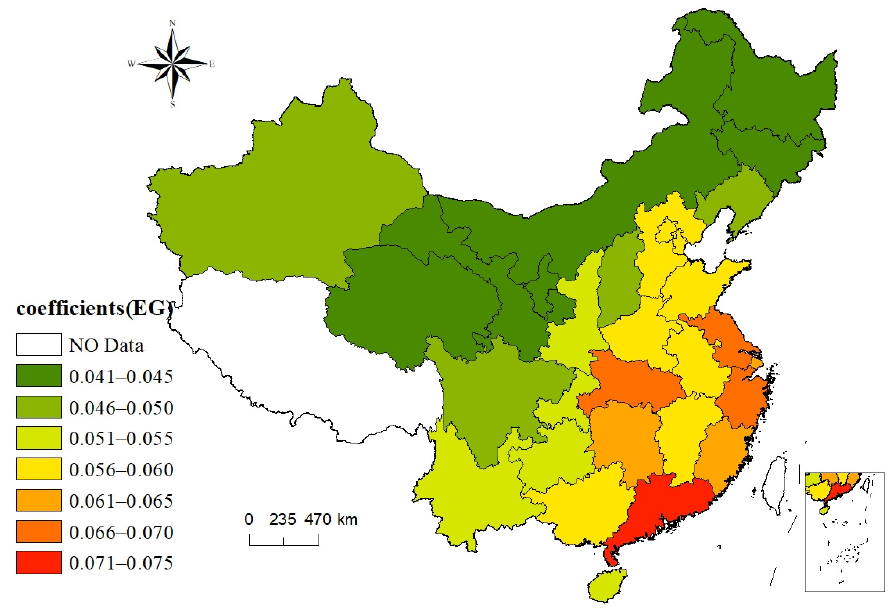
Figure 7. The impact of hydropower on provincial economic growth in 2017.